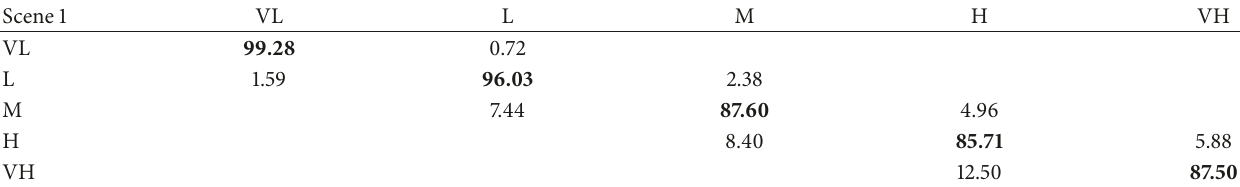
Table 4: The classification accuracy of our method (%).